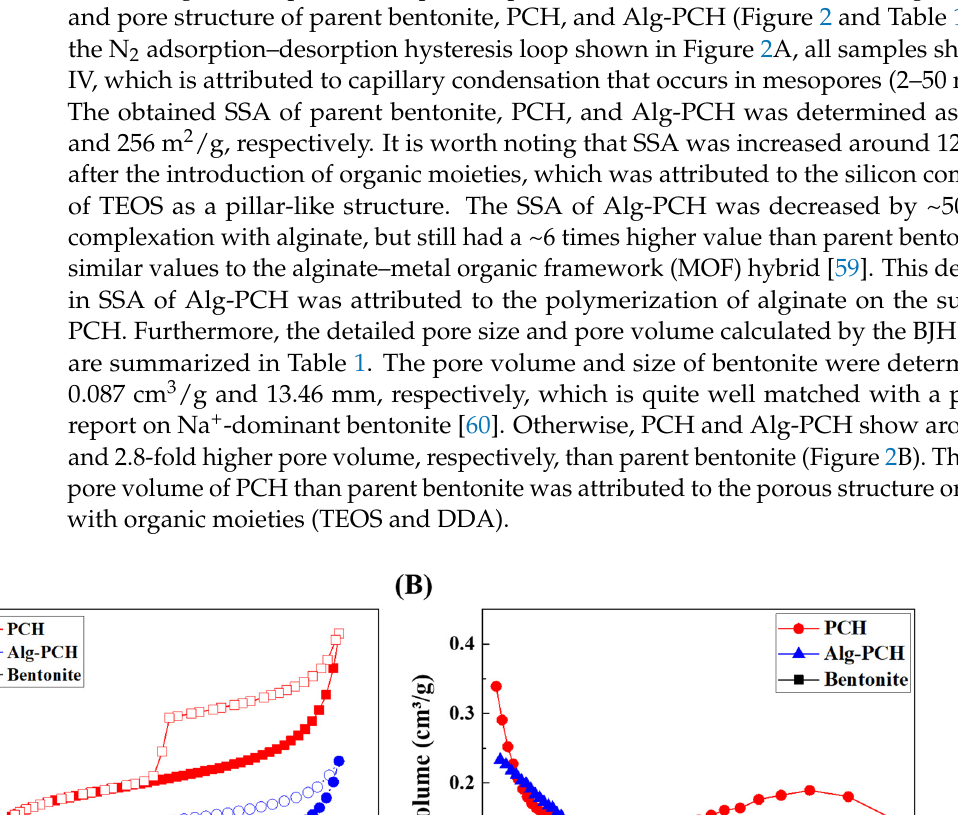
Figure 1. ( A ) Powder X-ray diffraction patterns of bentonite, PCH, and Alg-PCH (Q; quartz) and ( B ) FT-IR spectra of bentonite, PCH, alginate, and Alg-PCH.